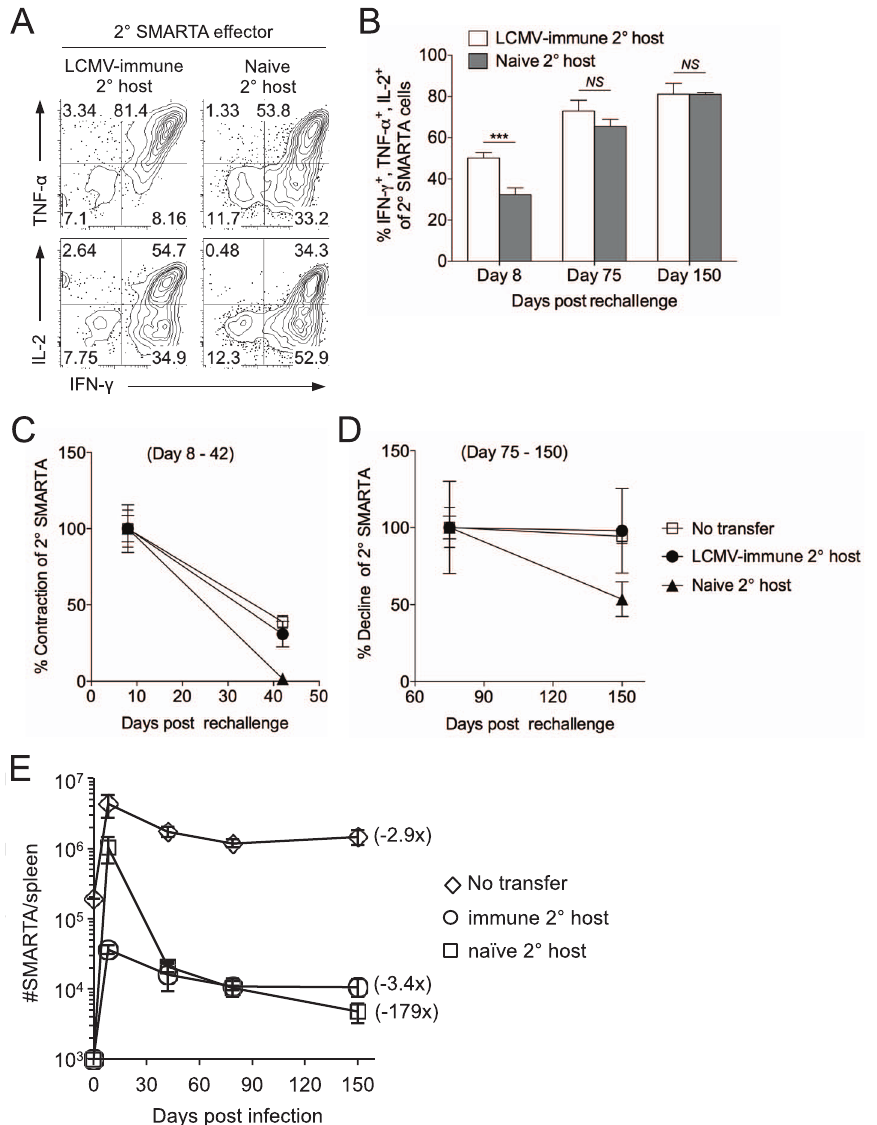
Figure 2. Secondary SMARTA effector cells generated after rechallenge in naı¨ve hosts have decreased ability to produce multiple cytokines and limited memory differentiation potential. LCMV-induced memory SMARTA cells ( . 42 days post-infection) were transferred into either LCMV-immune or naı¨ve hosts and rechallenged with Lm-gp61 as previously. A ) Representative flow plots gated on Thy1.1 + SMARTA cells indicate the frequency of secondary SMARTA Th1 effector cells in the spleen of either LCMV-immune or naı¨ve secondary hosts seven days after Lm- gp61 challenge that co-produced IFN c and TNF a or IFN c and IL-2 following ex vivo peptide restimulation. B ) Bar graph indicates the frequency of Thy1.1 + secondary SMARTA effector (day 8) and memory (days 75, 150) cells in the spleen that simultaneously produced IFN c , TNF a and IL-2 after in vitro peptide restimulation. C – D ) Graphs display the percent contraction of the secondary SMARTA effector cells in the spleen between day 8 and 42 (C) and the percent decline of ensuing secondary memory cells between day 75 and 150 (D) after Lm-gp61 rechallenge of SMARTA memory cells (Thy1.1 + ) transferred into naı¨ve or LCMV-immune secondary hosts (Thy1.2 + ), or of secondary SMARTA Th1 cells after rechallenge of LCMV-immune hosts without secondary transfer. E) Plot displays the total number of Thy1.1 + SMARTA cells in the spleen over a 150 day time course for each group. Numbers in parentheses indicate the fold decline in numbers between the peak of the secondary response (day 7) and day 150 post-rechallenge. Error bars indicate the SEM (n=3–4 mice/group). Results are representative of two separate experiments. *** p , .001; NS =not significant, as determined by student’s t-test.